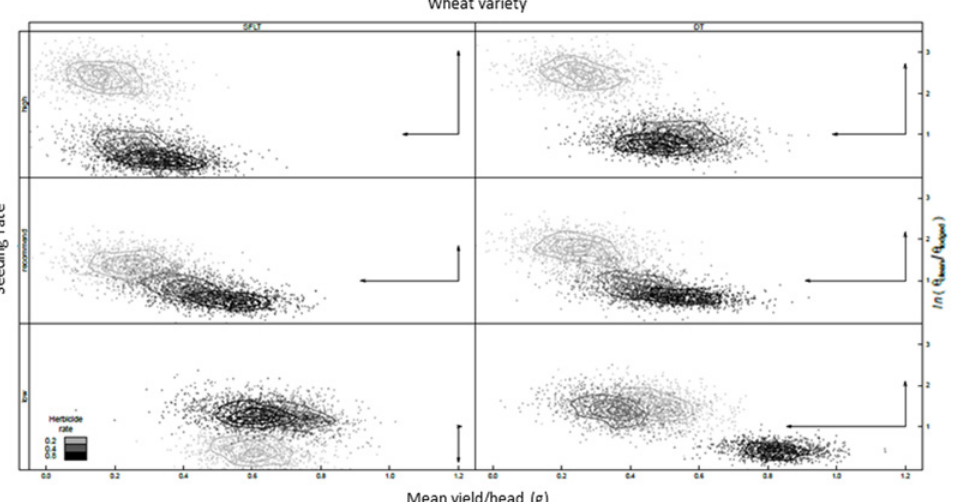
Fig 5. Joint posterior density for the rate of uninfested wheat stems ((relative to lodged stems on a log-odds scale on a log-odds scale) and mean yield per wheat head in the uninfected category for wheat variety (columns), seeding density (rows), and herbicide application rate. Arrows represent the median change on the vertical and horizontal axes with increasing Bromus tectorum pressure and contour lines are 95%, 75% and 50% highest posterior density region. Crop variety treatments are drought tolerant spring wheat (DT) and Cephus cinctus tolerant spring wheat